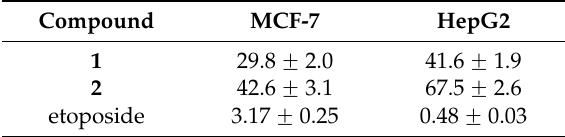
Table 3. Cytotoxic activity of target compounds (IC 50 , µ